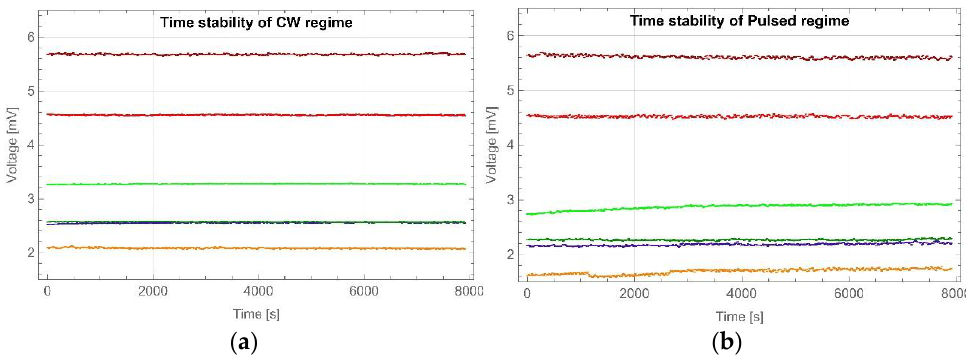
Figure 3. Scheme of signal intensity change in time for: ( a ) continuous (CW) and ( b ) pulsed LED regimes.